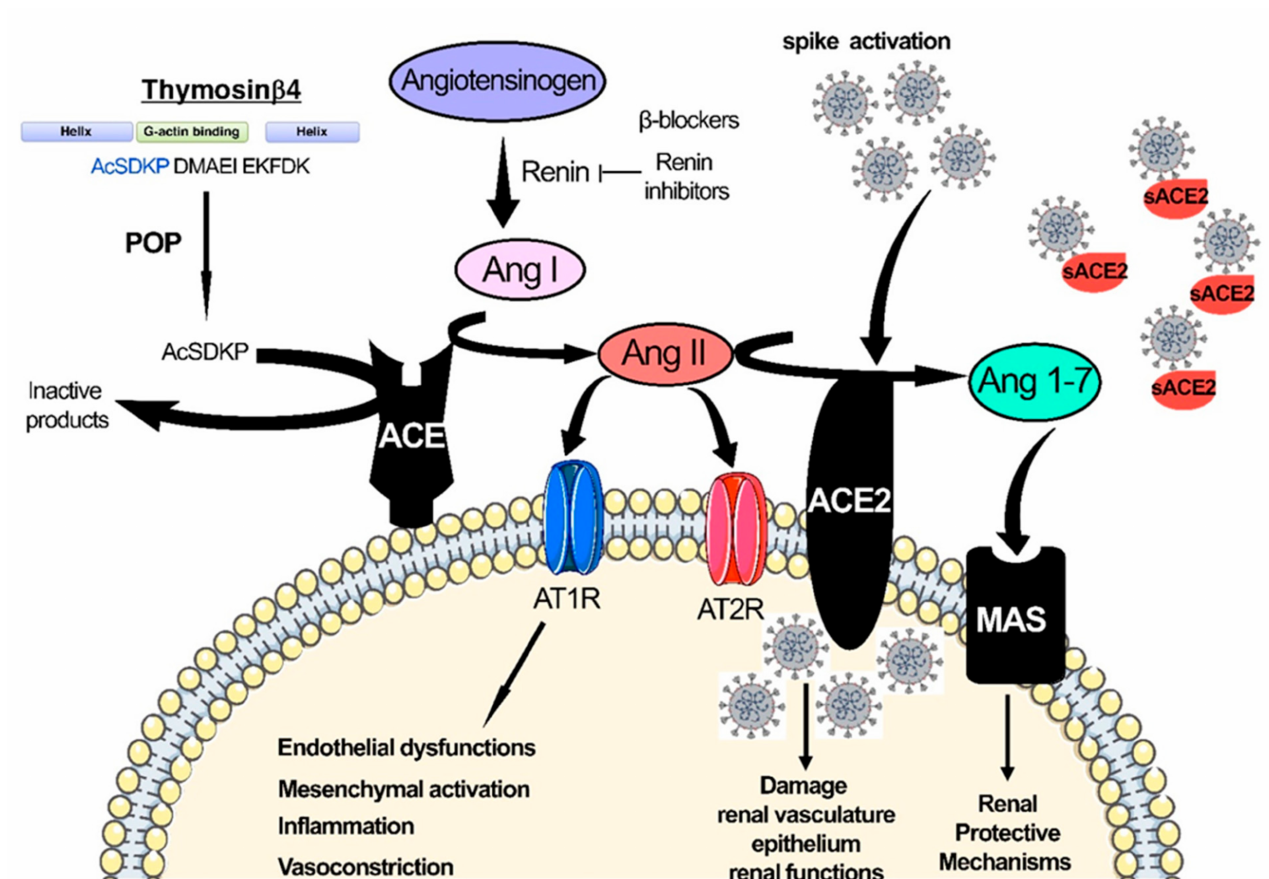
Figure 1. SARS-CoV-2 infection-associated disruption in the renin-angiotensin